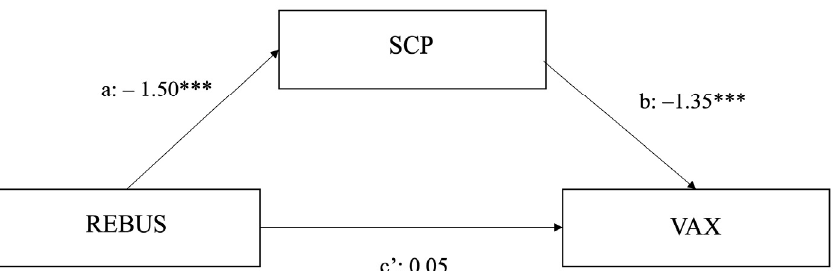
Figure 1. Mediating effect of SCP on the relationship between creative problem solving and vaccine acceptance (VAX). *** p < 0.001. [a = direct effect of REBUS on SCP; b = direct effect of SCP on VAX; c’ = direct effect of REBUS on VAX after controlling for SCP].